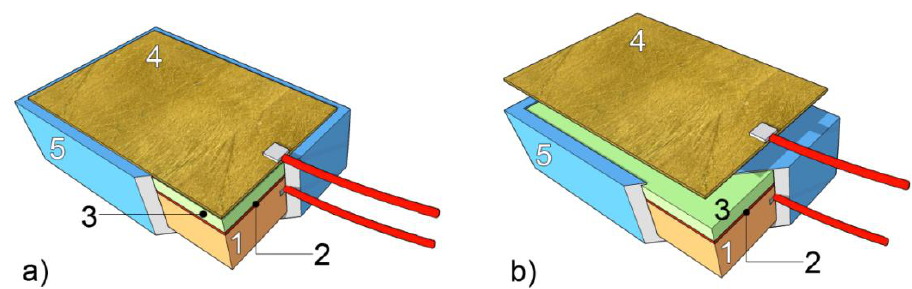
Figure 2. General model of a galvanic sensor ( a ) with detail of the gold leaf overlapped ( b ).The complete stratigraphy of the sensor includes: (1) metallic substrate; (2) cuprite layer; (3) patina of corrosion products; (4) gilding; (5) electric insulation cover.